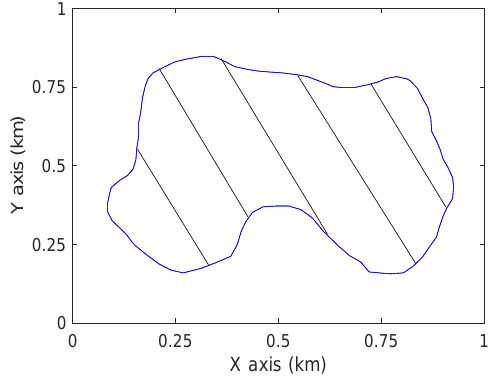
Figure 5. The ground region D .